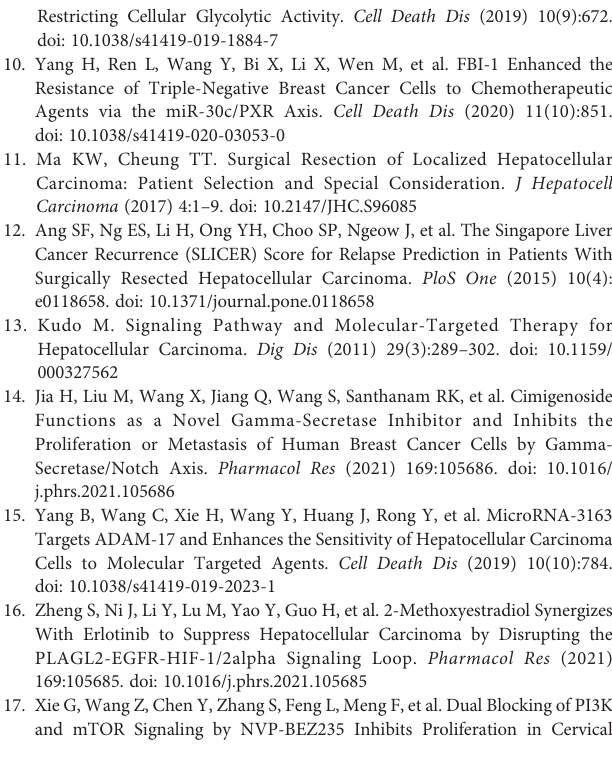
Supplementary Figure 1 | The synthetic route of CK-3. Supplementary Figure 2 | The HPLC fi ngerprint of CK-3 in the presence work. Supplementary Figure 3 | HR-MS spectrum of compound CK-3 in the presence work. Supplementary Figure 4 | 1H-NMR spectrum of compound CK-3 in the presence work. Supplementary Figure 5 | CK-3 enhanced the expression of E-Cadherin in HCC cells E-cadherin expression of HCC cell lines after treatment with CK-3 was evaluated with a western blot. All blotted proteins were normalized to GAPDH. Data are presented as the mean ± SD of three independent experiments (n = 3). *P < 0.05. Supplementary Figure 6 | CK-3 suppressed the PI3K/AKT/mTOR pathways in Hep3B and Bel7402 cells. Effects of CK-3 on p-ERK and ERK expression were evaluated. The bar graphs show the relative levels of PTEN, p-AKT, AKT, p-mTOR, mTOR, p-p70S6K, p70S6K, p-ERK, and ERK. All blotted proteins were normalized to GAPDH. Supplementary Figure 7 | CK-3 suppressed the MAPK/ERK pathways in Hep3B and Bel7402 cells. Effects of CK-3 on p-ERK and ERK expression were evaluated. The bar graphs show the relative levels of PTEN, p-AKT, AKT, p-mTOR, mTOR, p-p70S6K, p70S6K, p-ERK, and ERK. All blotted proteins were normalized to